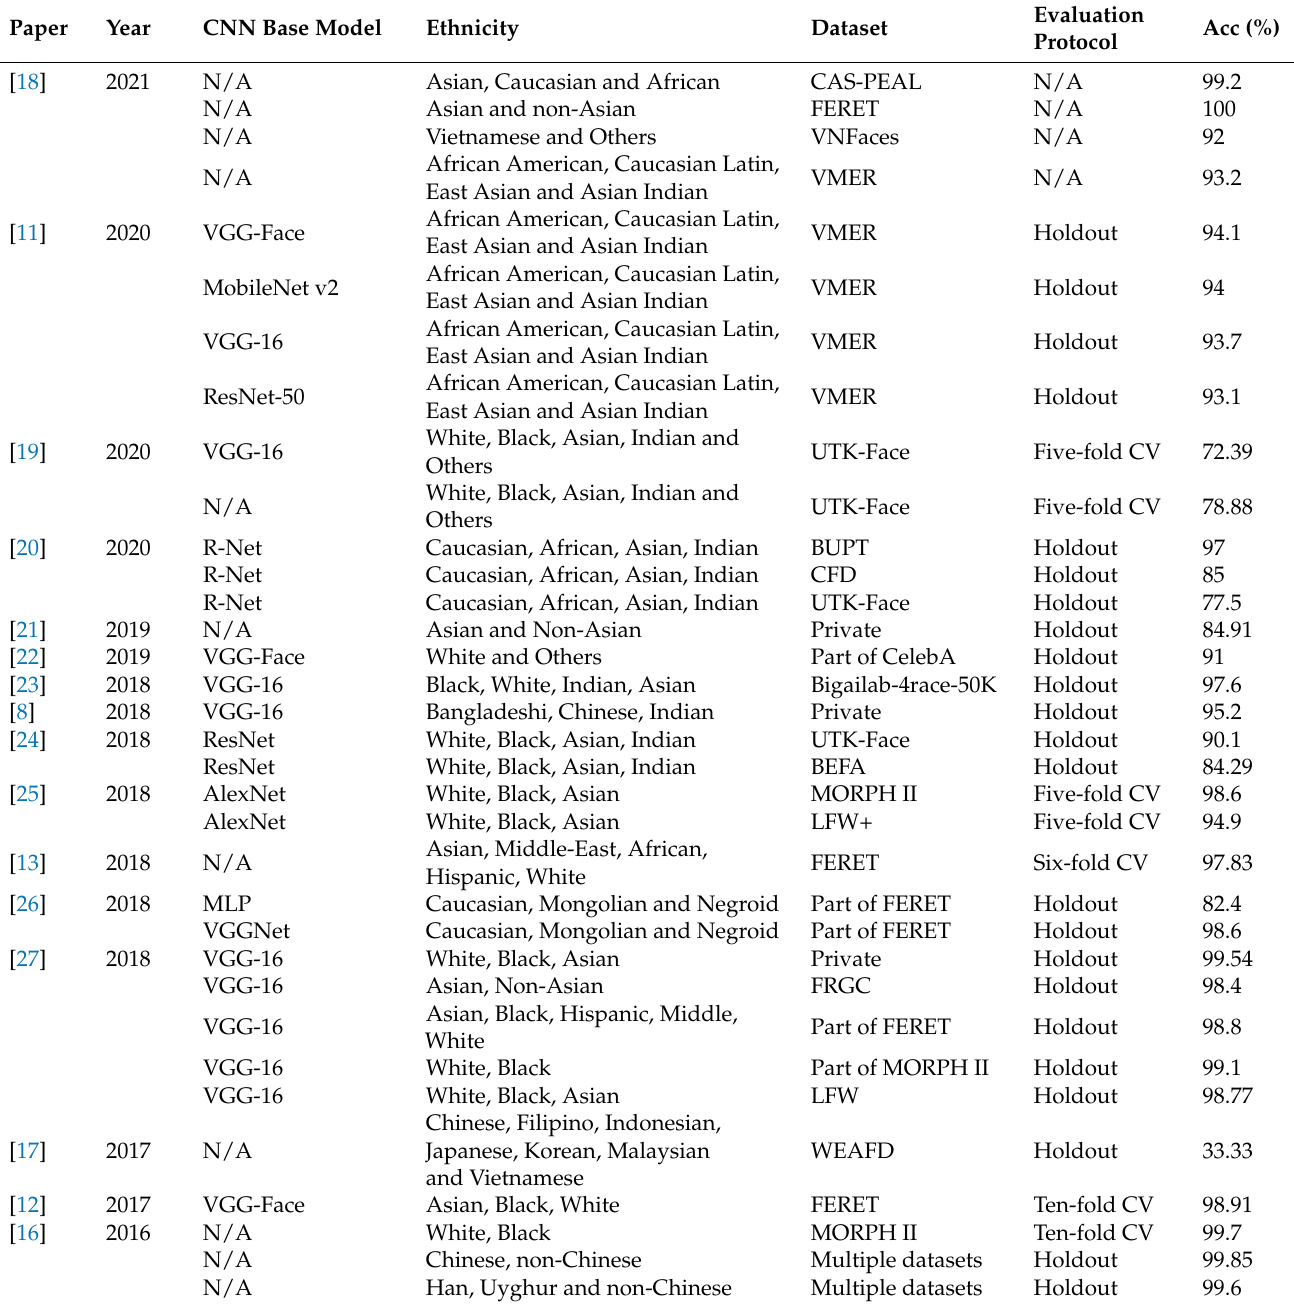
Table 1. Overview of ethnicity classification